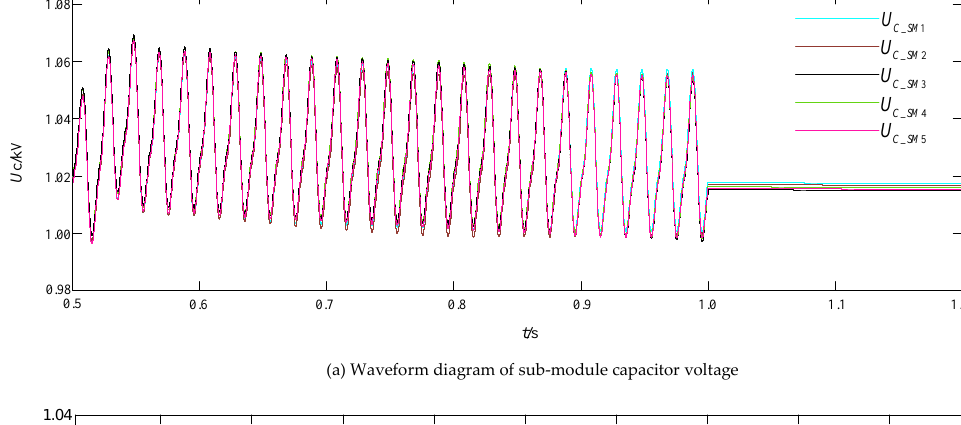
Figure 11. Bridge arm current waveform.